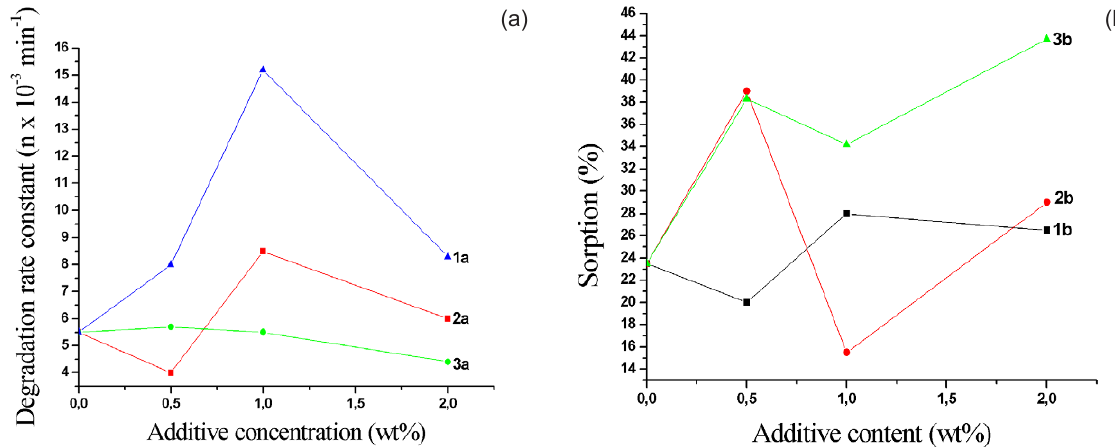
Figure 4. Relations of degradation rate constant under UV irradiation (a) and catalysts sorption ability (b) on additive concentration: ThO ThF